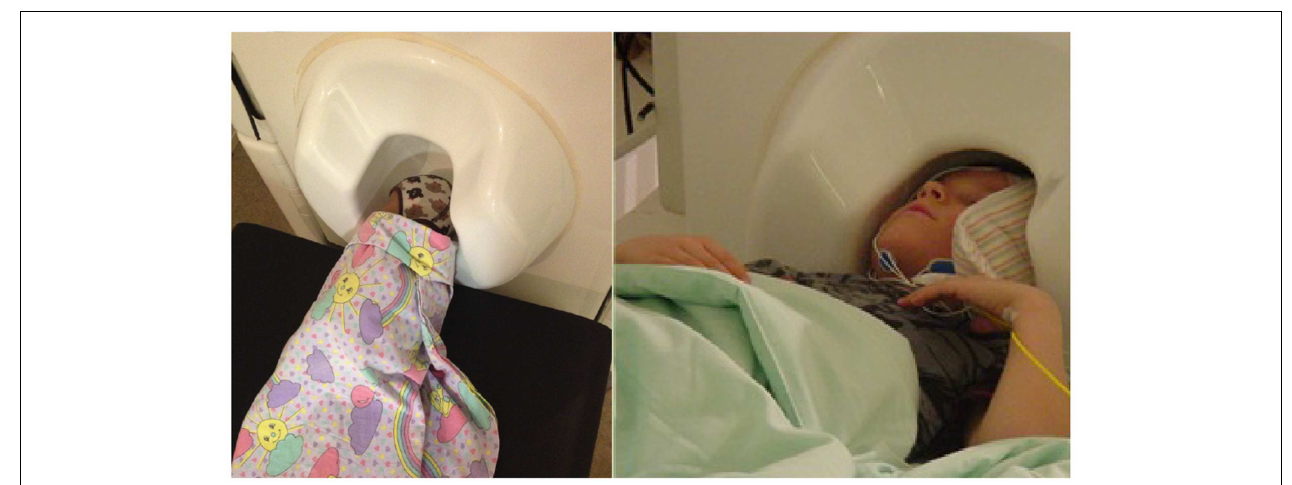
be recorded. Right: 6-year-old child sleeping with his head in an adult-size helmet.The head is positioned close to the right side of the helmet, the left hemisphere is further away from the sensors, and a small pillow fills the gap, restricting head